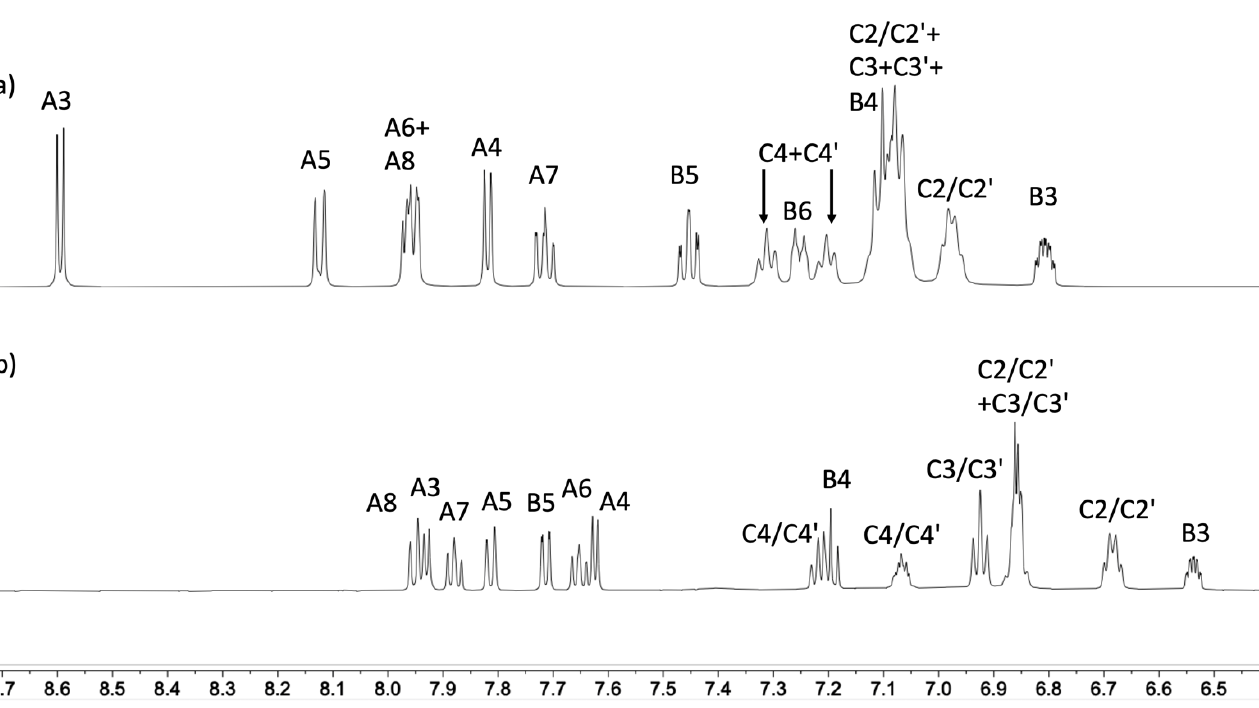
Figure 5. 1 H NMR spectra (aromatic region) of (a) [Cu(POP)(biq)][PF 6 ] (acetone-d 6 , 500 MHz, 298 K) and (b) [Cu(xantphos)(biq)][PF 6 ] (C 2 D 2 Cl 4 , 600 MHz, 298 K). See Scheme 2 for the atom labelling scheme.